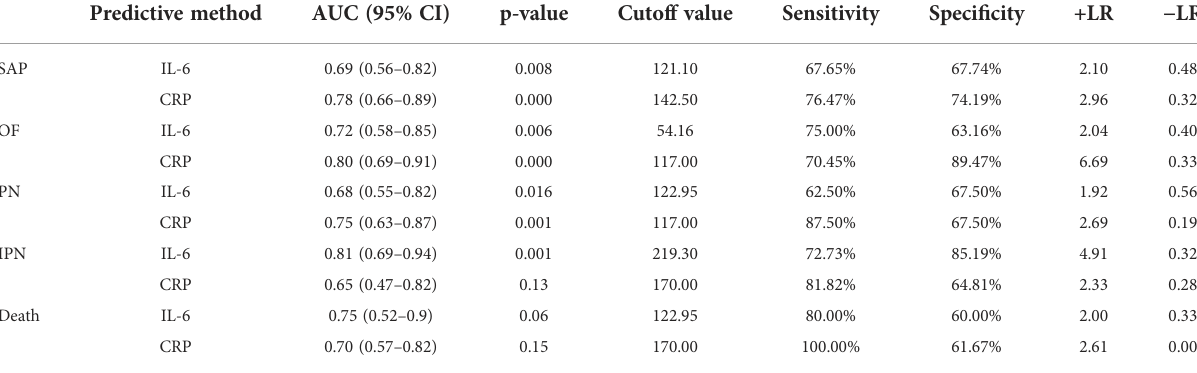
TABLE 4 Comparison of IL-6 and CRP for the prediction of SAP, OF, PN, IPN, and death. Predictive method